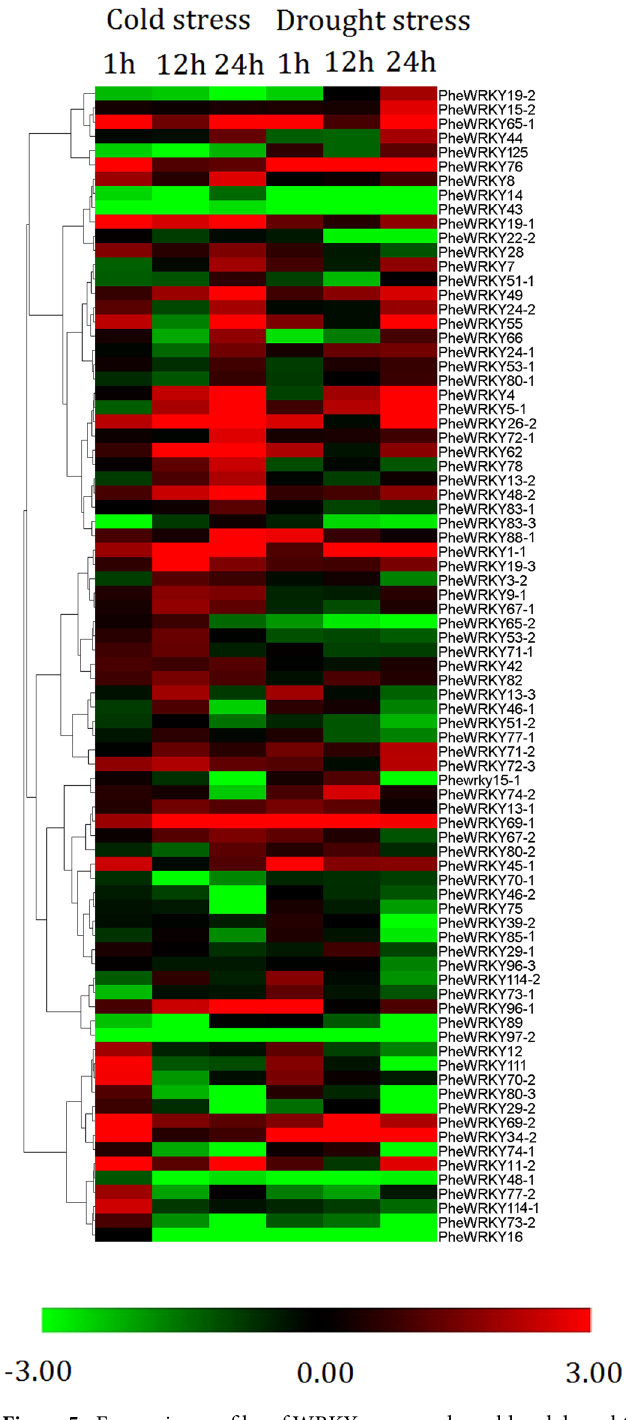
Figure 5. Expression profiles of WRKY genes under cold and drought stress. The expression results were obtained by qRT-PCR, and the relative expression levels of PheWRKY genes under various treatments compared to the controls were used for hierarchical cluster analysis with Cluster 3.0. qRT-PCR analysis was based on three biological replicates of each sample and three technical replicates of each biological